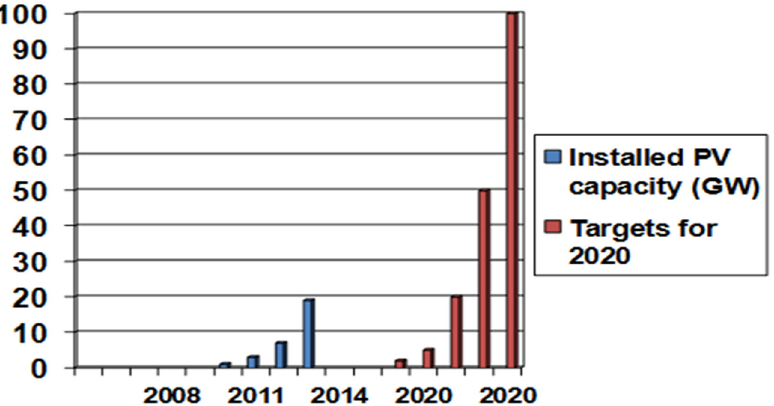
Figure 2. Share of green power 1998–2014 and targets for 2020/2025 in Germany (BMUB 2015).